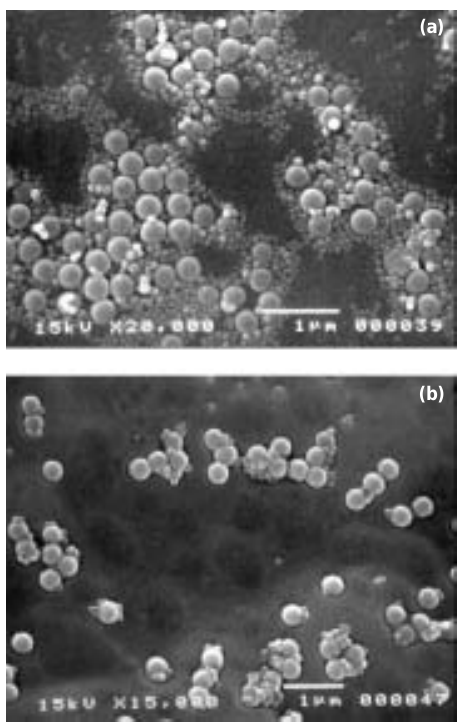
Fig. 6 Scanning electron microscopic images of silica particles in the (a) influent and (b) effluent